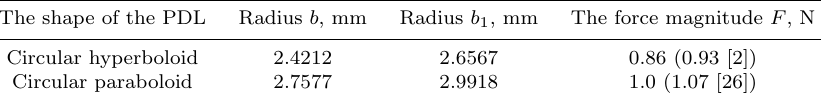
Magnitudes of force required for translational displacement of tooth root with circular cross-section in PDL at value of 0 . 2 microns (magnitude in parentheses are force obtained in [2,26] under the assumption of the periodontal tissue incompressibility). The shape of the PDL